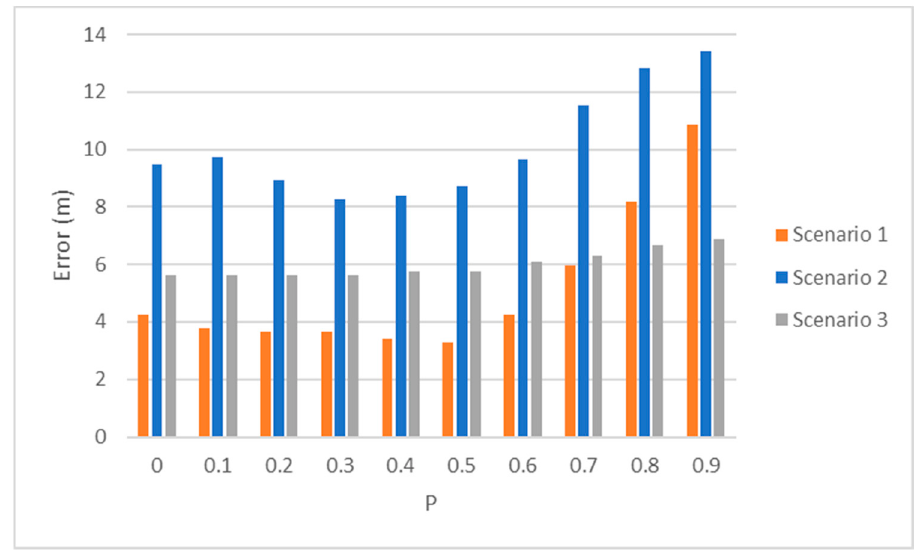
Figure 17. Localization error for different p- values for the three scenarios.